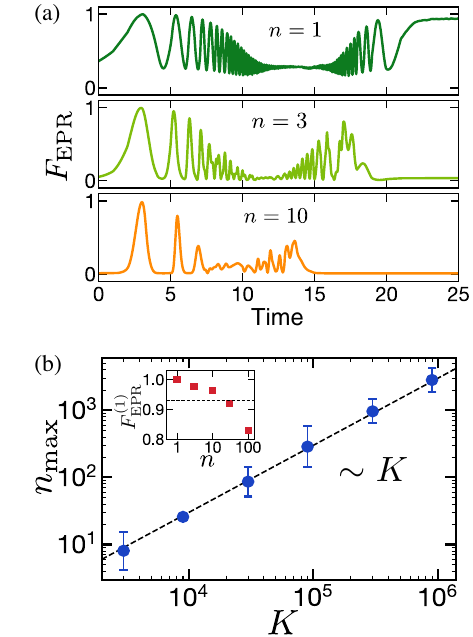
FIG. 4. Teleportation of multiple qubits in 0D RUCs. (a) Many-body teleportation fidelity F as a function of EPR time for teleporting n ¼ 1 , 3, 10 qubits with fixed coupling strength ( g ¼ 177 π ). Compared to a single qubit, the decay- revival profile for multiple qubits is shifted to earlier times, since multiqubit operators both have a larger size width and saturate the system size earlier. Moreover, multiqubit telepor- tation is not possible at late times, resulting in a trivial late-time fidelity (Sec. VII A). (b) Numerical results for the channel capacity n as a function of the number of coupled qubits K , max which exhibit a clear linear scaling. To determine the channel 1 Þ capacity, we compute the maximum per qubit fidelity F ð for EPR a fixed number of qubits, n , and couplings, K , while allowing the coupling strength, g , and evolution time to vary. For fixed 1 Þ K , F ð decreases as the number of qubits n is increased, as EPR depicted in the inset for K ¼ 9000 . The channel capacity n is max defined as the maximum number of qubits for which the fidelity is above a fixed threshold (dashed